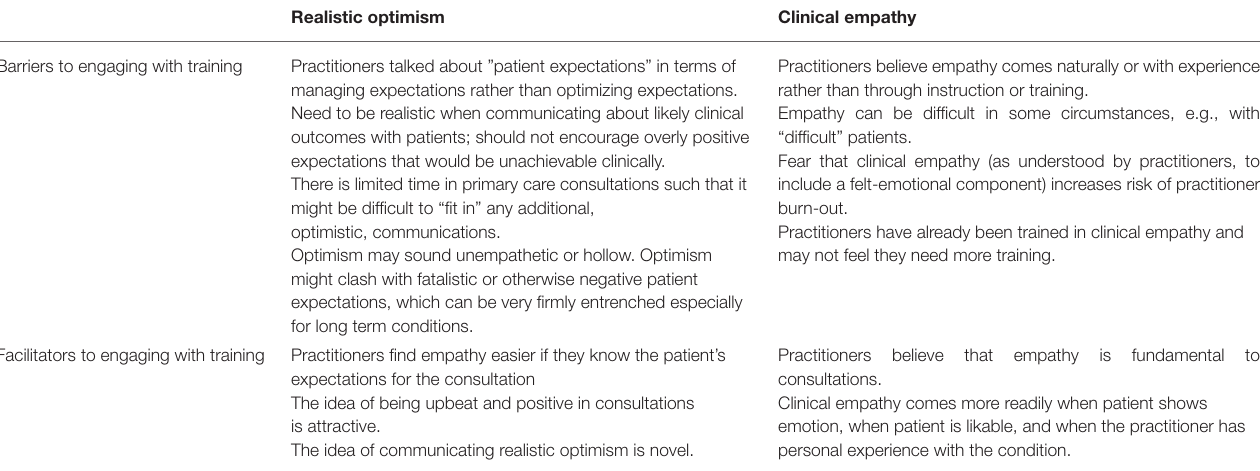
TABLE 4 | Barriers and facilitators to engaging with training, identified from practitioner